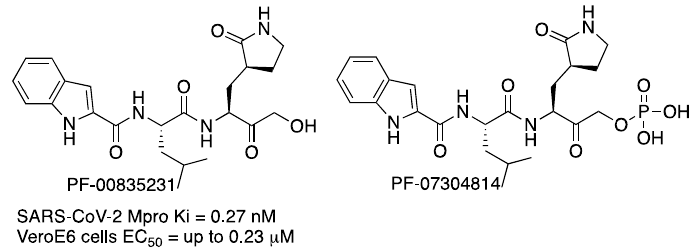
Figure 6. Pfizer inhibitors of SARS ‐ CoV ‐ 2 Mpro enzyme.